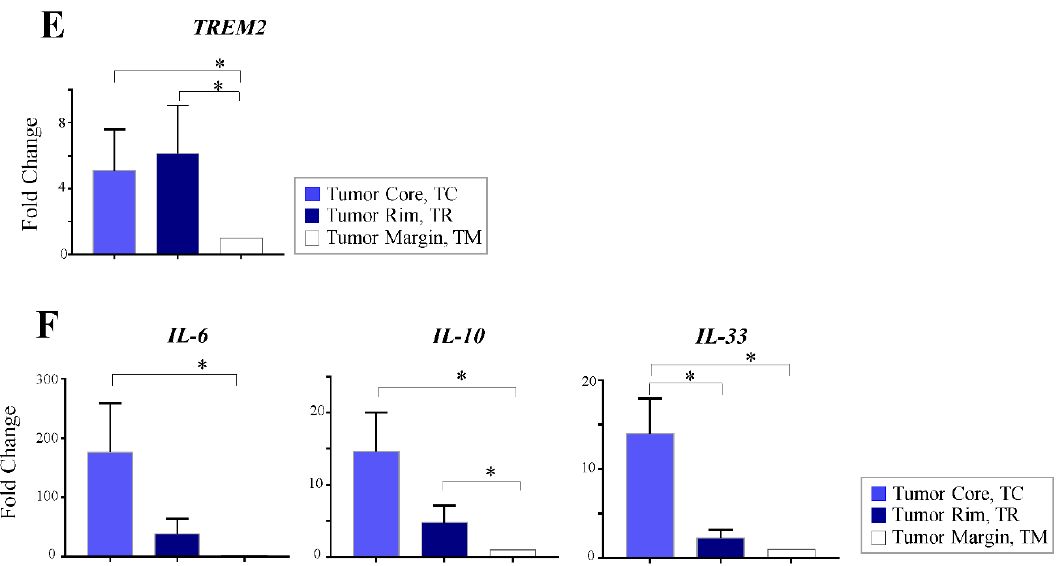
Figure 6. Expression profiles of TREM2 and proinflammatory cytokine genes in GBM tumor samples. ( A , B ) RT-PCR assay in the KDM5C Low and KDM5C High subgroups. ( C ) Scatter plot reporting the correlation—by linear regression analysis—of NANOG and IL6 in the KDM5C Low and KDM5C High subgroups. ( D ) IL6 expression analysis in GBM patients with (Epilepsy+) or without epilepsy (Epilepsy − ). ( E , F ) RT-PCR assay in 5-ALA FGS tissues. Each transcript analysis was performed in triplicate, and the samples were normalized with the TBP gene. The bars indicate the mean ± SEM of repeated experiments. Asterisks indicate statistical significance compared with the healthy control samples: * p < 0.05. In the scatter plots, the average expression value of the healthy control samples was used as a reference. The Pearson’s correlation coefficient (r) and p -values ( p ) are indicated on the top of each plot.